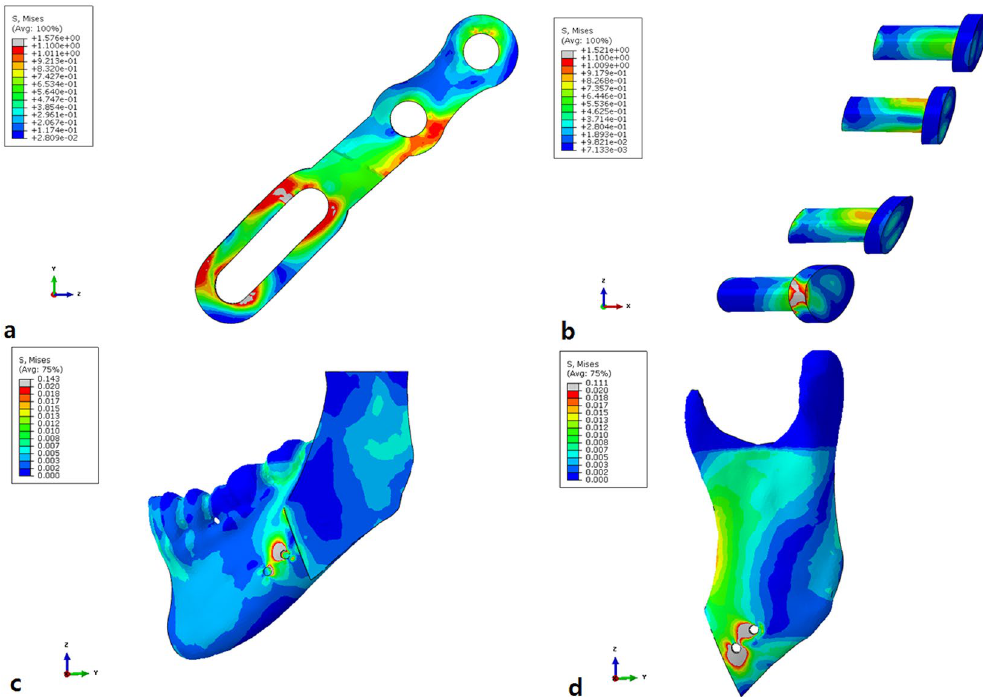
Figure 1. Finite-element model demonstrating stresses in the sliding-plate model. ( a ) Sliding-plate, ( b ) Four screws, ( c ) Distal segment (buccal view) and ( d ) Proximal segment (buccal